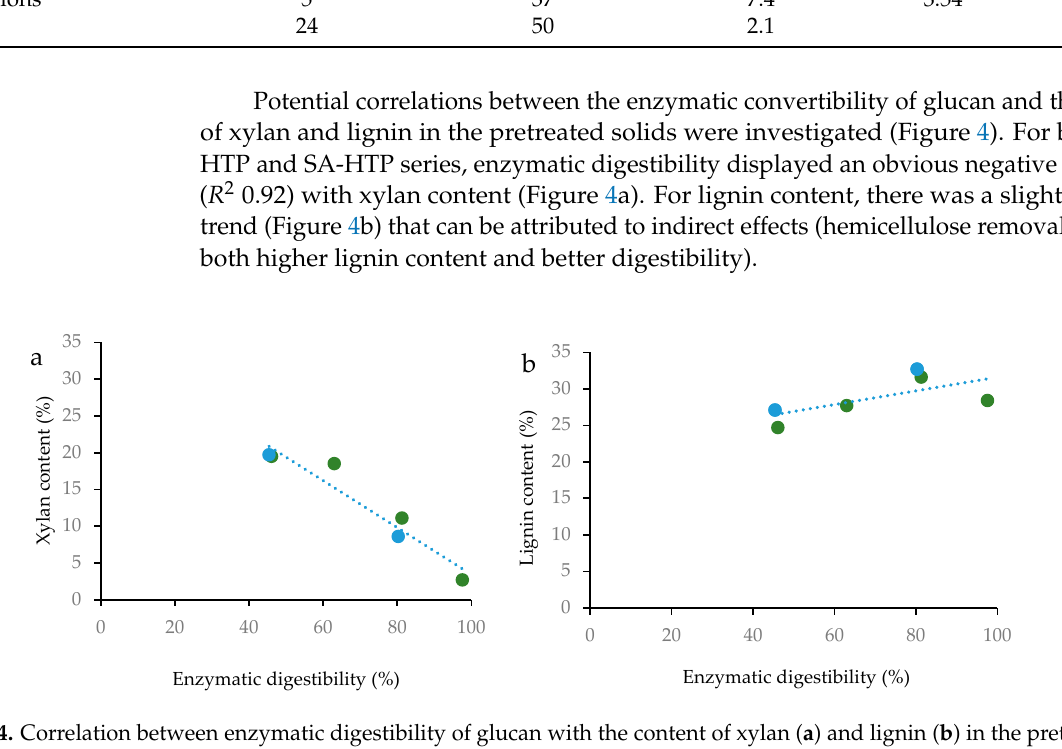
Figure 4. Correlation between enzymatic digestibility of glucan with the content of xylan ( a ) and lignin ( b ) in the pretreated solids. The green markers are for A ‐ HTP and the blue markers are for SA ‐ HTP. R 2 = 0.92 (xylan) and R 2 = 0.45 (lignin). The plotted lignin content was determined using Py ‐ GC/MS.